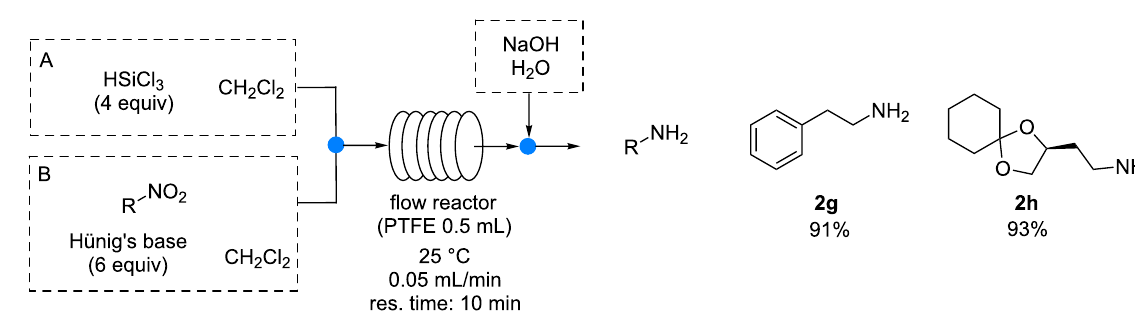
Scheme 3: Continuous-flow reduction of aliphatic nitro compounds.